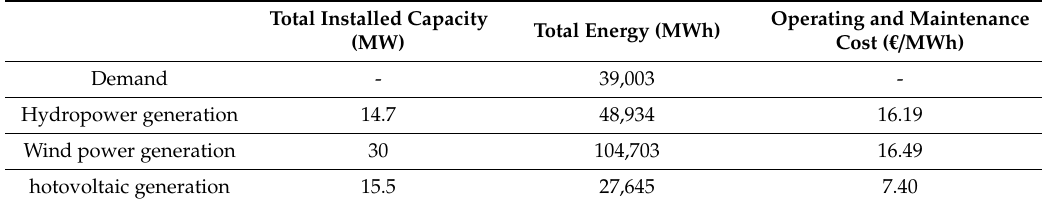
Table 2. Global data on demand, generation and production